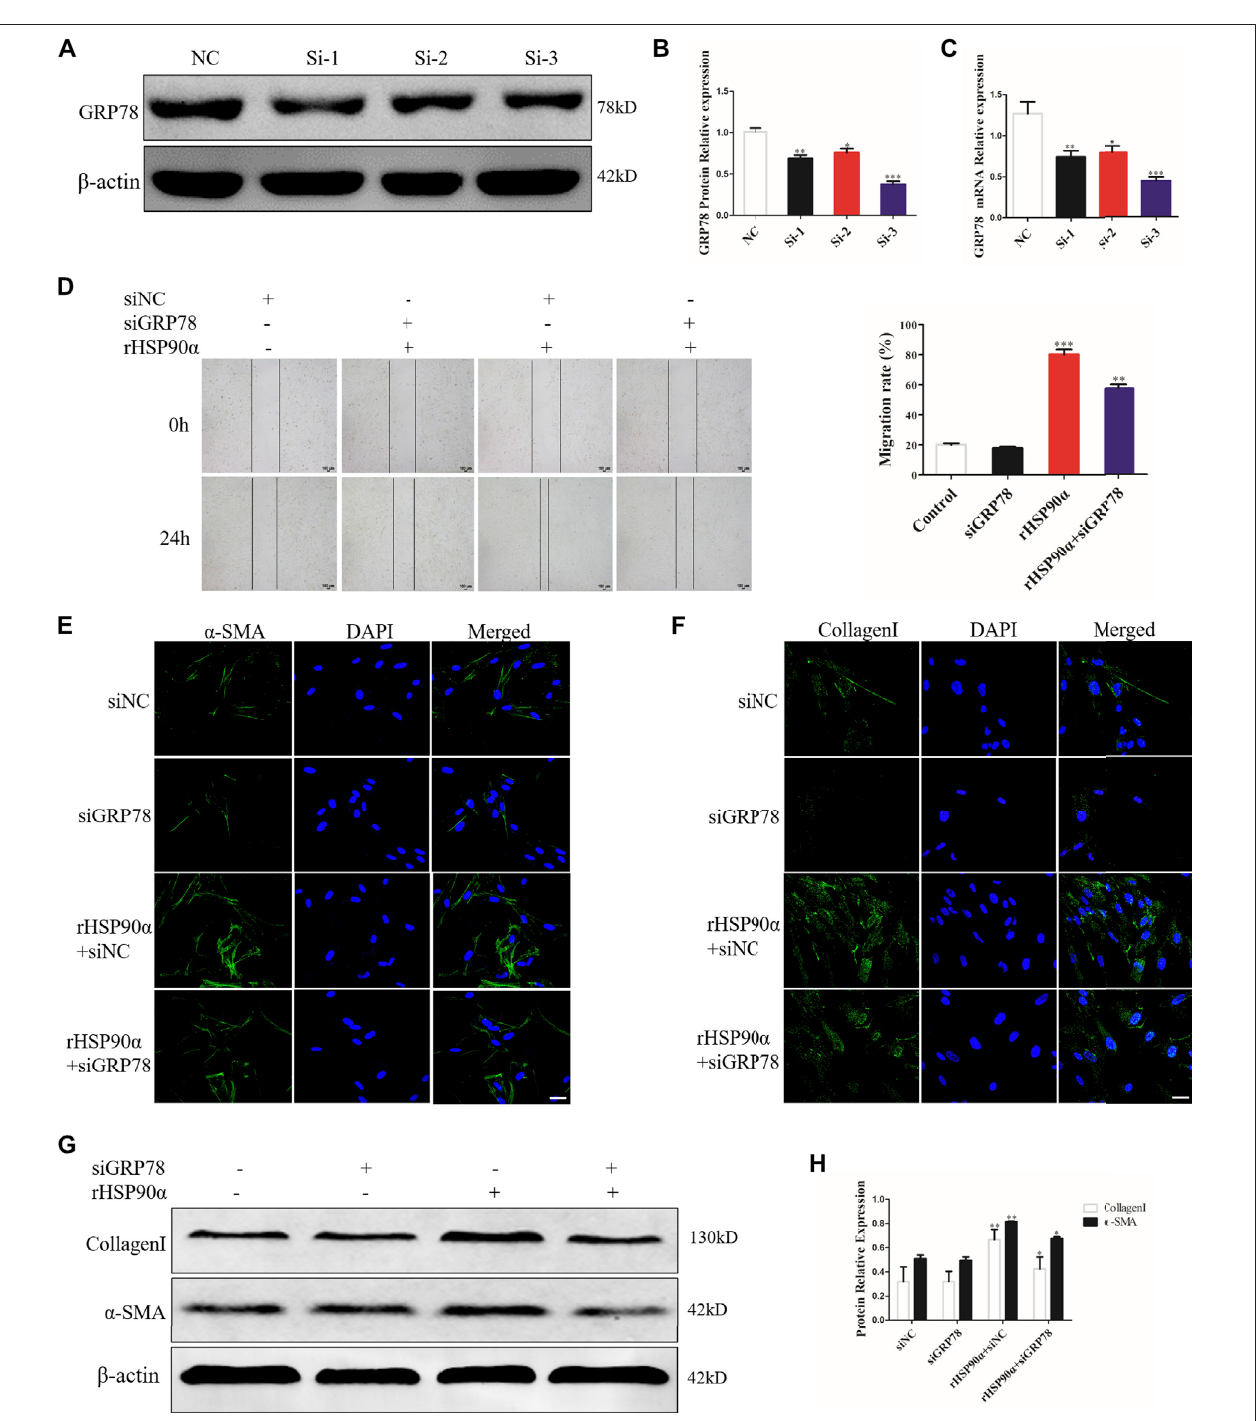
FIGURE 5 | GRP78 is essential for lung fi broblast activation induced by eHSP90 α . IMR90 cells were transfected with siGRP78 or siNC and the ef fi ciency was assessed by western blot (A,B) and qPCR (C) . Cell migration was examined in IMR90 cells by a wound healing assay (D) . Lung fi broblasts activation was assessed by immuno fl uorescence staining for α -SMA and CollagenI (E,F) , representative staining images of α -SMA – positive stress fi bers (green), CollagenI-positive collagen deposition (green) and DAPI (blue) showing nuclei under confocal laser scanning microscopy (scale bar (cid:1) 50 μ m). (G,H) . The expression of CollagenI and α -SMA were measured by western blot. β -actin was used as an internal control. * p < 0.05, ** p < 0.01.